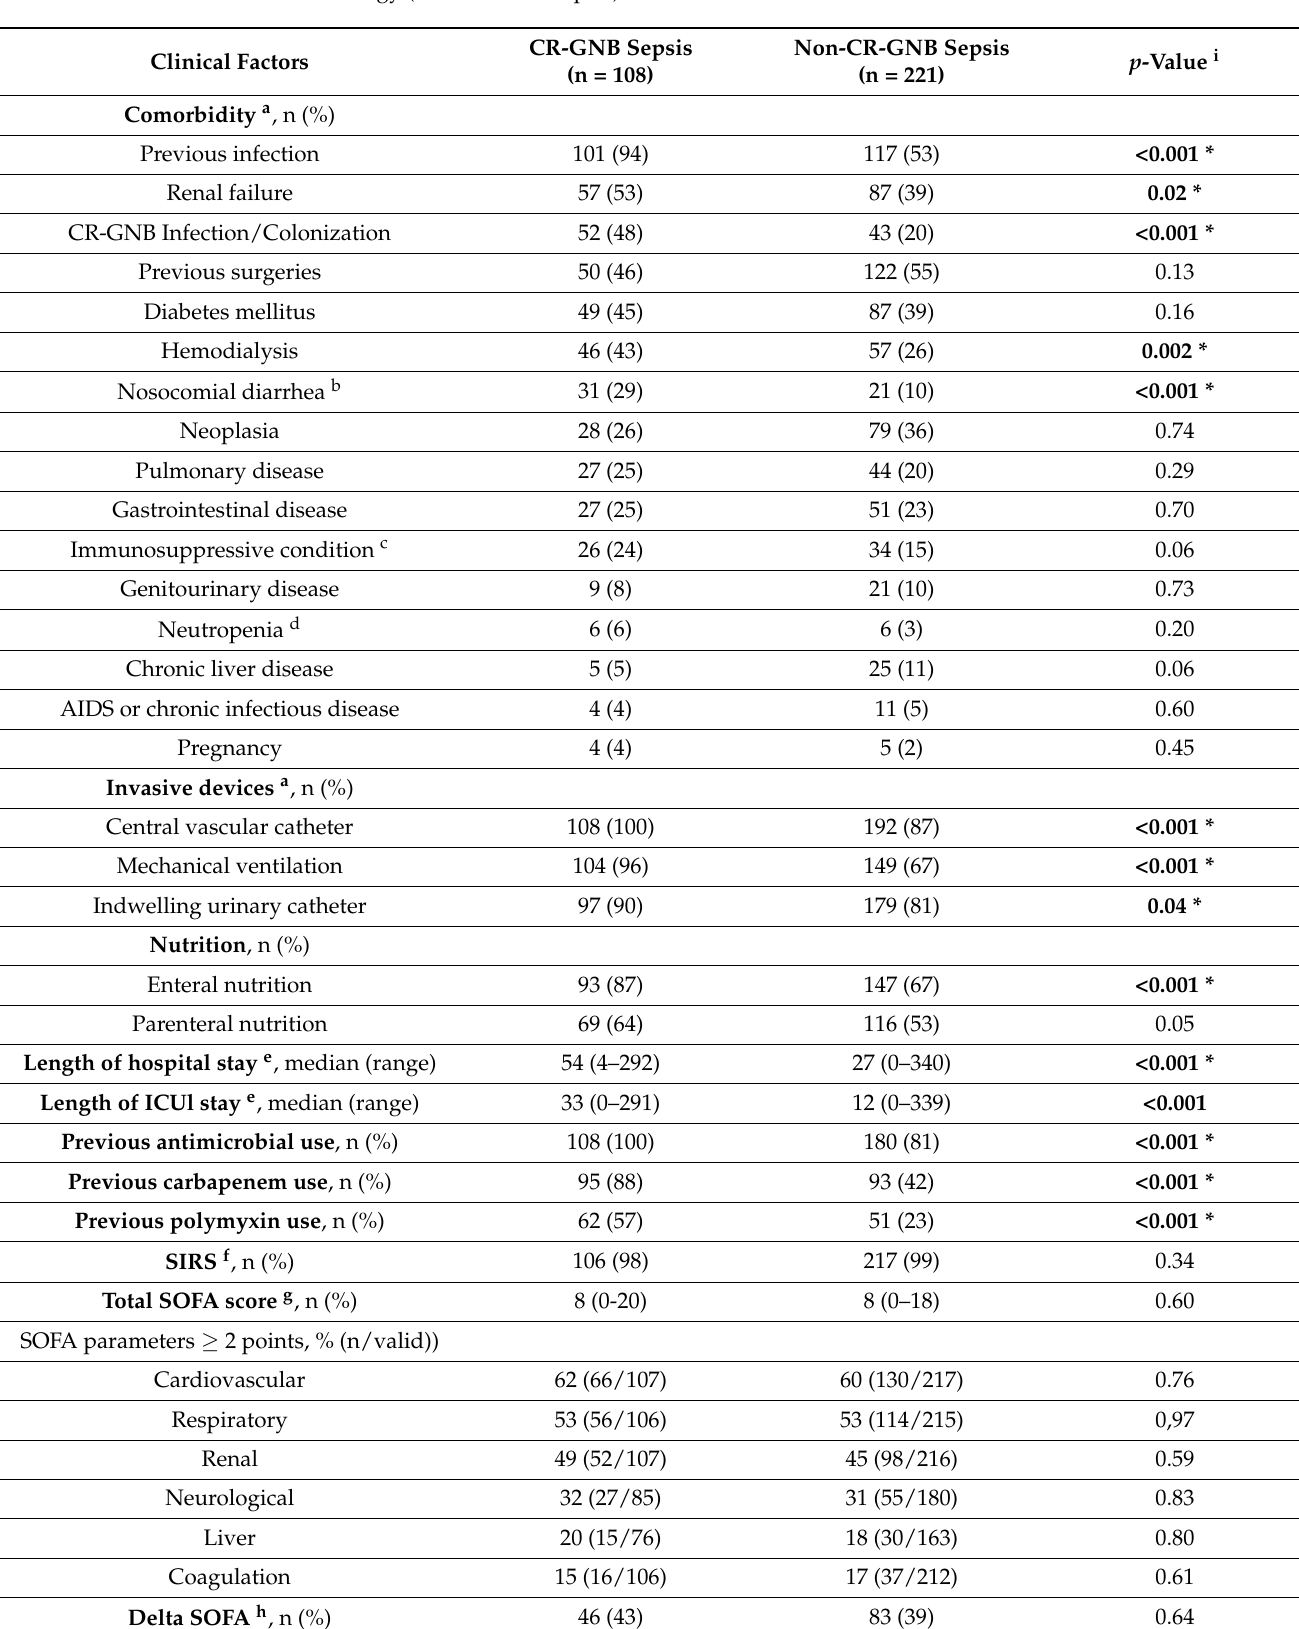
Table 2. Clinical features of sepsis episodes caused by CR-GNB and by another or undetermined etiology (non-CR-GNB